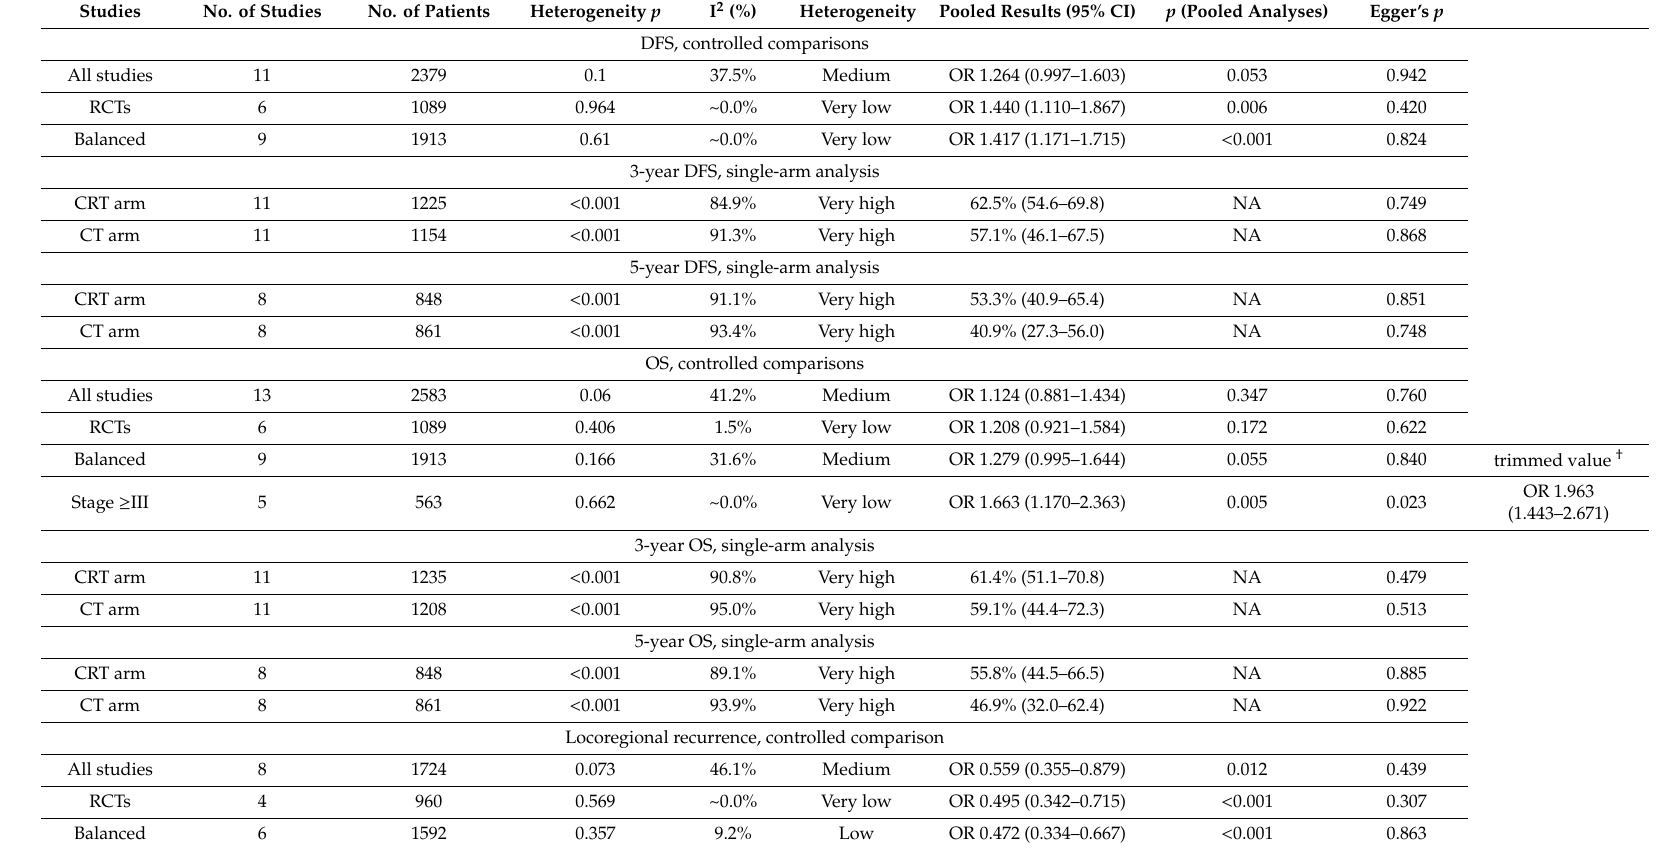
Table 3. Pooled results of